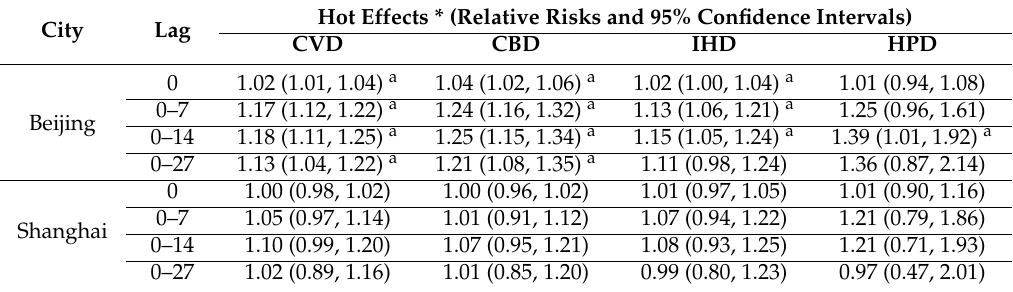
Table 3. The cumulative hot effects (relative risks (RRs) and 95% CI) on mortality from cardiovascular disease, cerebrovascular disease, ischemic heart disease and hypertensive disease of Beijing and Shanghai,